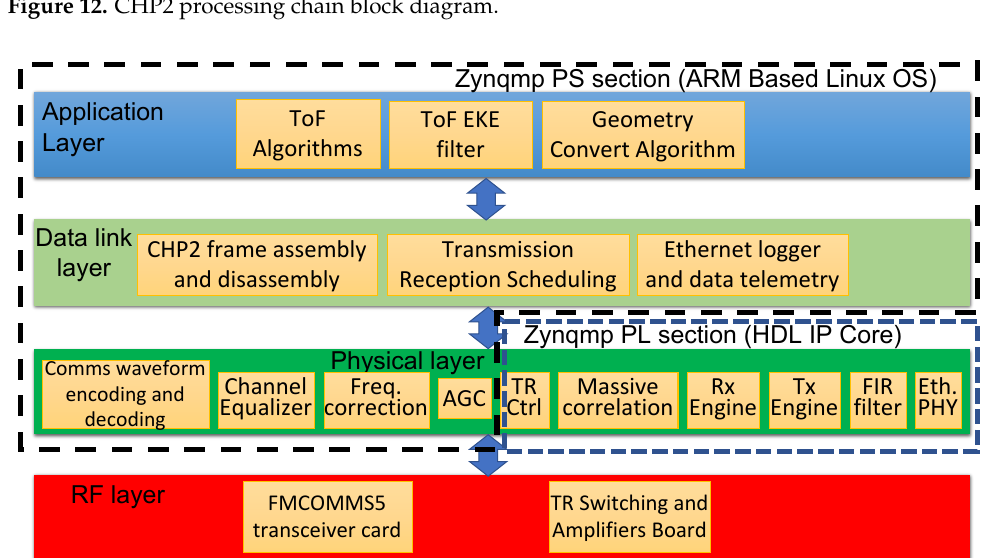
Figure 13. CHP2 system functions organized by OSI